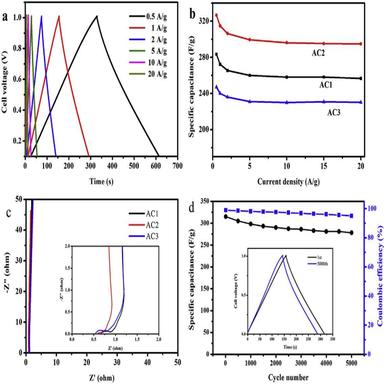
(a) GCD curves of AC2 at various current density, (b) plot of the specific capacitance of AC1, AC2 and AC3 measured by GCD test, (c) Nyquist plot of AC1, AC2 and AC3, (d) stability test for AC2 at 1 A/g for 5000 cycles.